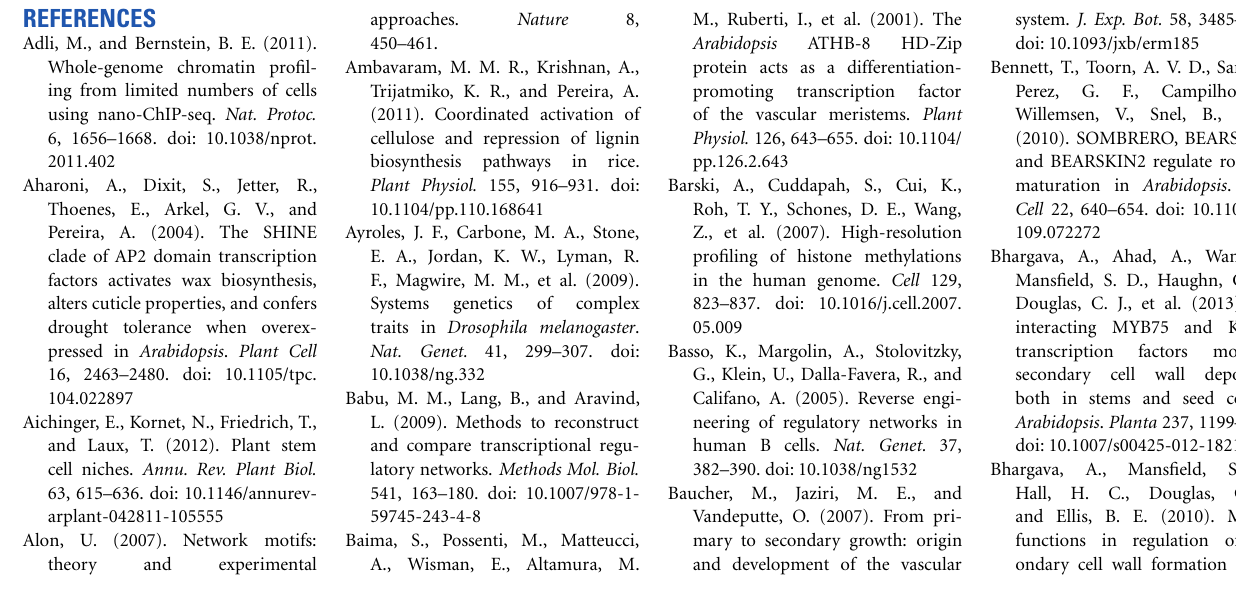
dashed edges; known indirect regulatory relationships; light blue edges, protein–protein interactions. Structural genes are indicated as square nodes, transcriptional activators as circular nodes, transcriptional repressors as diamond-shaped nodes, and transporter proteins (WAT1) as triangles. Nodes are color-coded according to known biological processes: blue, signaling; green, cellulose biosynthesis; yellow, hemicelluloses biosynthesis; black, programmed cell death; purple, lignin biosynthesis; white, unknown function. Transcriptional regulators colored in orange are involved in the regulation of more than one type of SCW